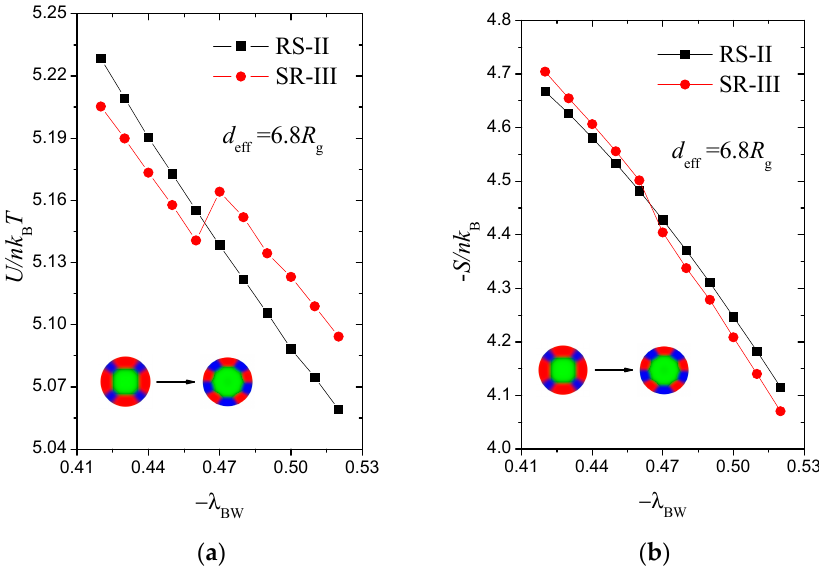
Figure 9. ( a ) Internal energy, U / nk B T , as functions of the B-attractive intensity, − λ BW , for RS-II and SR-III phases with d eff = 6.8 R g . ( b ) Entropic energy, − S / nk B T , that contributes to the free energy for RS-II and SR-III phases.